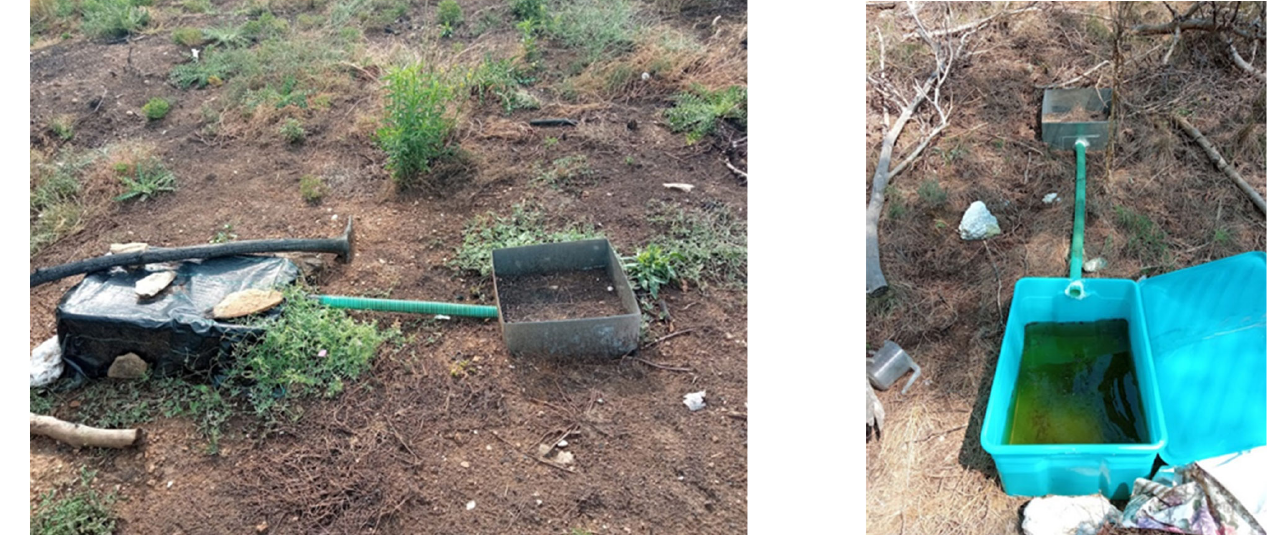
Figure 10. Experimental setup for the measurement of surface runoff ( left ). Water gathered in the plastic tank after an intense rainfall event ( right ).